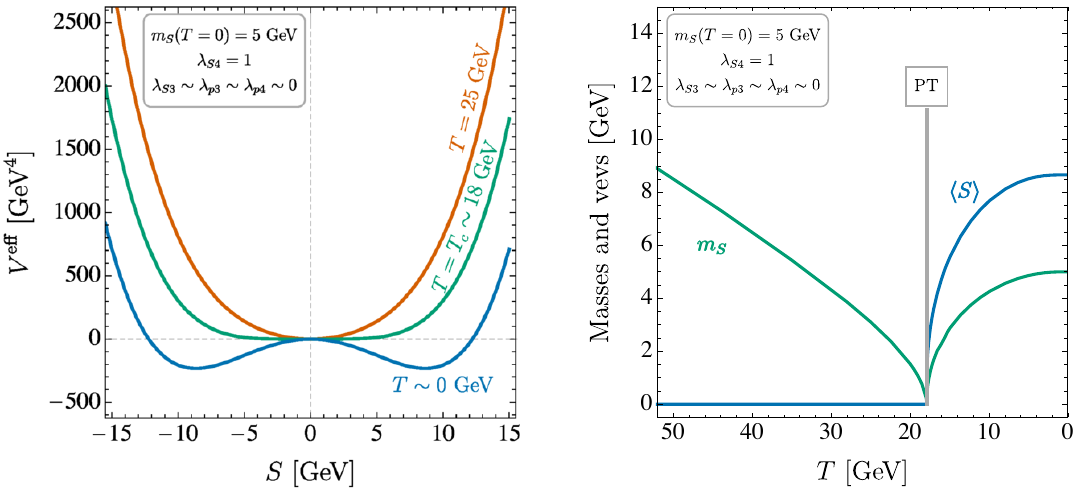
Figure 2 . The new scalar e(cid:11)ective potential at a relatively high temperature, at T = T c and at T (cid:24) 0 GeV, (left). A constant term has been subtracted at each T so that V e(cid:11) (0) = 0. The evolution of the new scalar mass and vev with temperature, (right), with the temperature of the phase transition indicated. Note that we neglect contributions